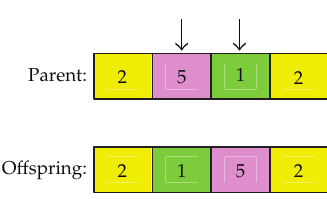
Figure 2: Example of single parent crossover